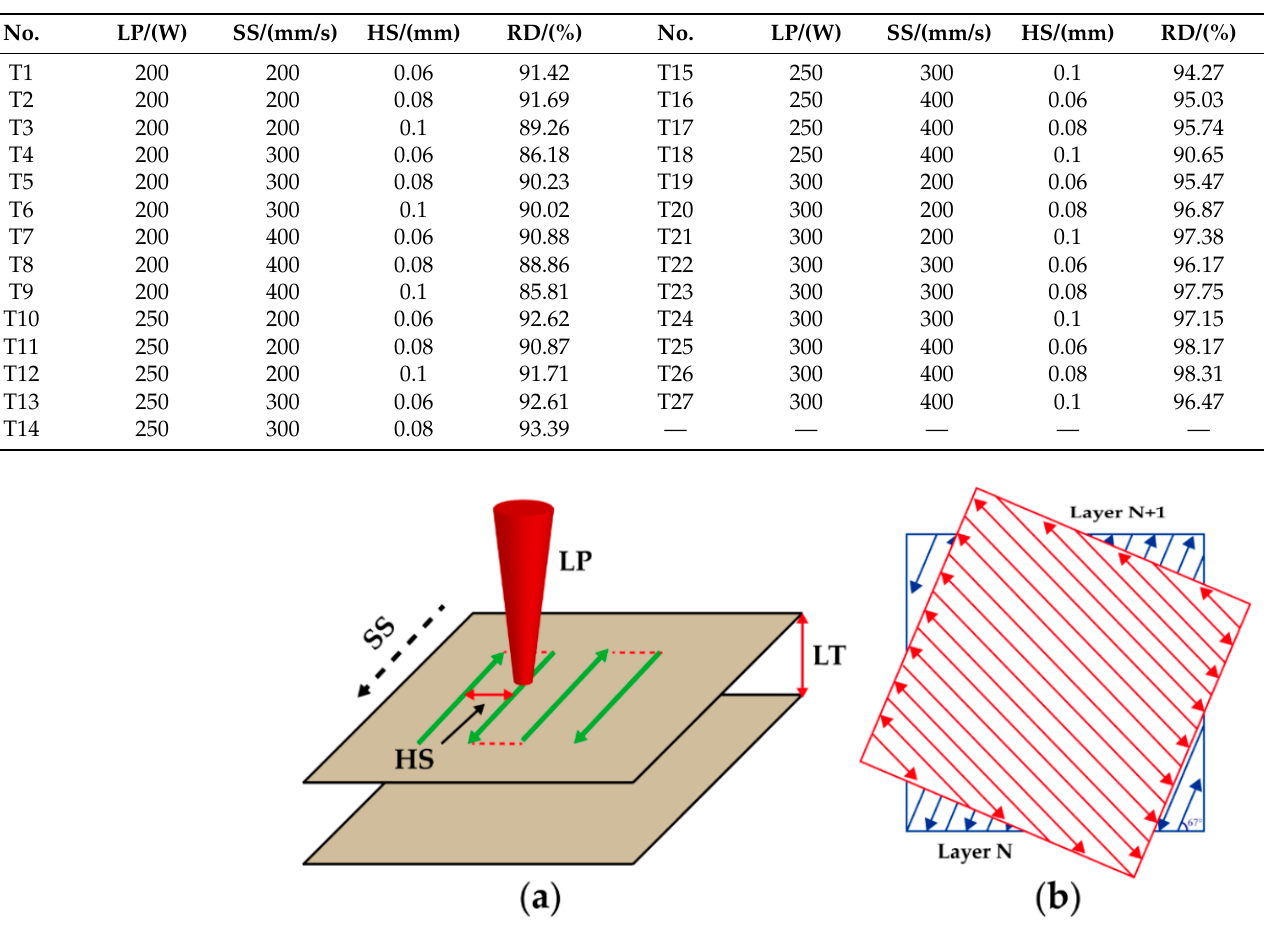
Figure 3. ( a ) Illustration of process parameters; ( b ) scanning strategy used in this work.